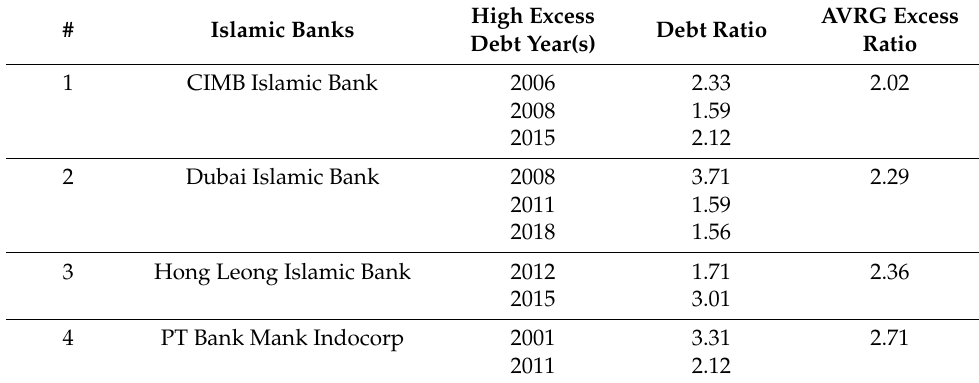
Table 2. High Excess Leverage among Islamic